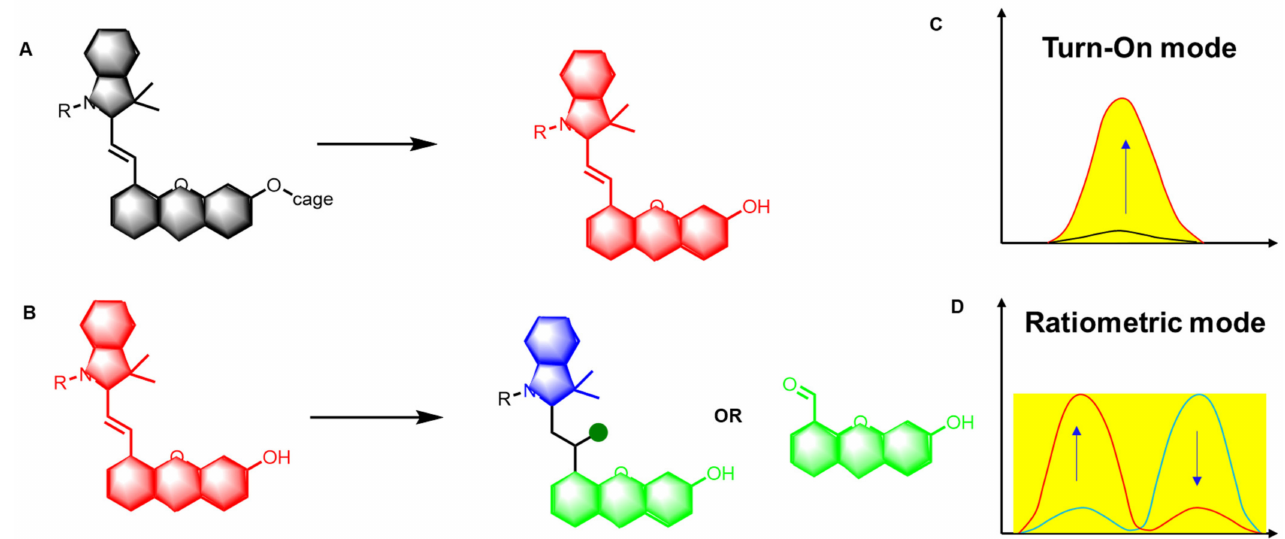
Figure 2. Design principles for activatable fluorescence probes. ( A ) Design principles of turn-on fluorescent probes. ( B ) Design principles of ratio-based fluorescent probes. ( C ) Image description of turn-on fluorescent probes. ( D ) Image description of ratio-based fluorescent